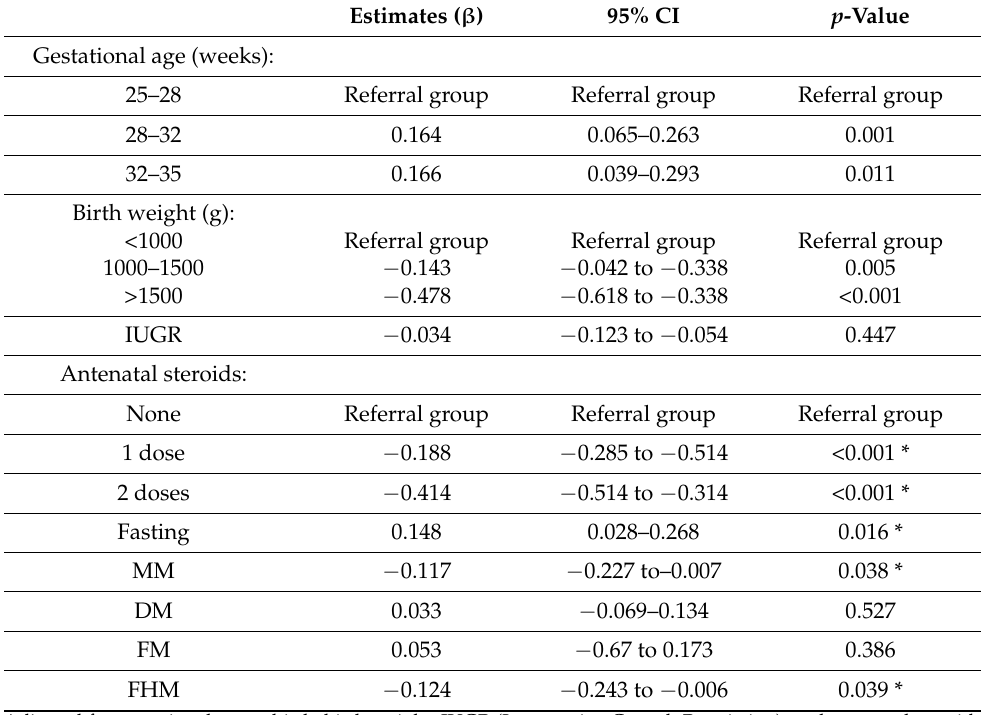
Table 5. Relationship between feeding strategies and NEC across three time points (3, 7, and 14 days): results from generalized linear